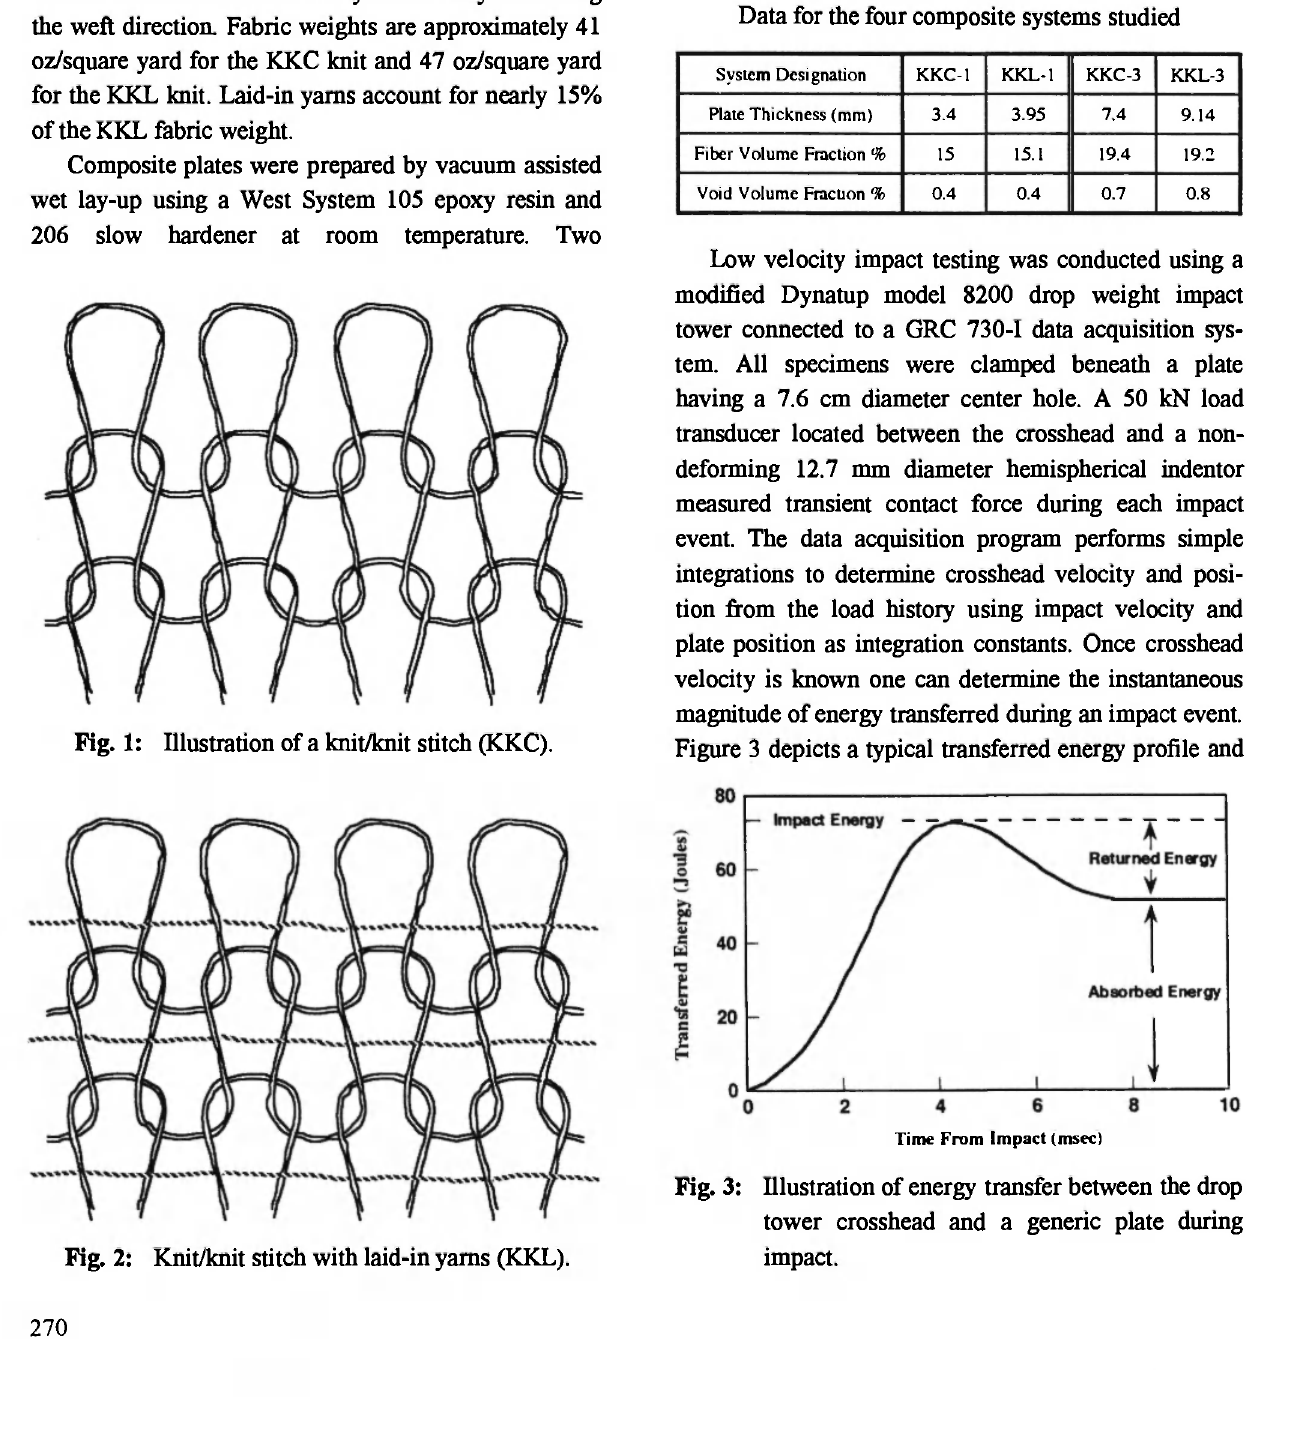
Fig. 3: Illustration of energy transfer between the drop tower crosshead and a generic plate during